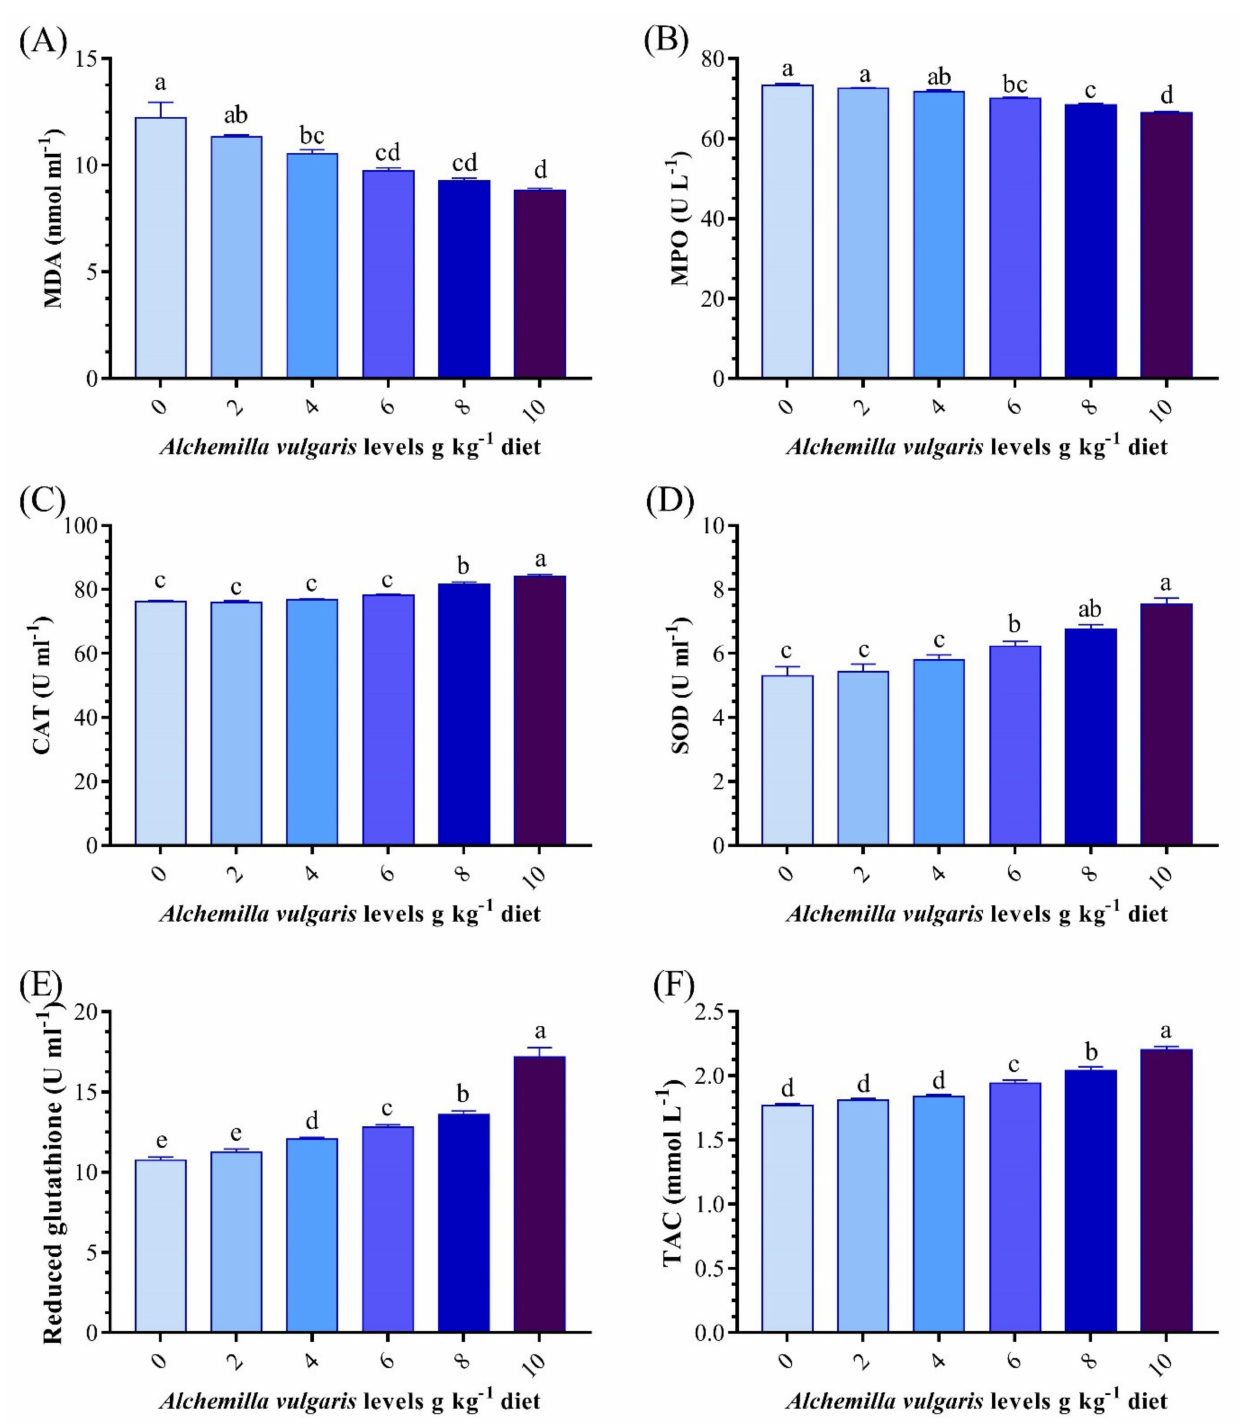
Figure 3. Effect of Alchemilla vulgaris dietary supplementation on antioxidant biomarkers in the serum of O. niloticus . ( A ) Malondialdehyde, ( B ) myeloperoxidase, ( C ) catalase, ( D ) superoxide dismutase, ( E ) reduced glutathione, ( F ) total antioxidant capacity. Columns bearing different letters are significantly different at p <